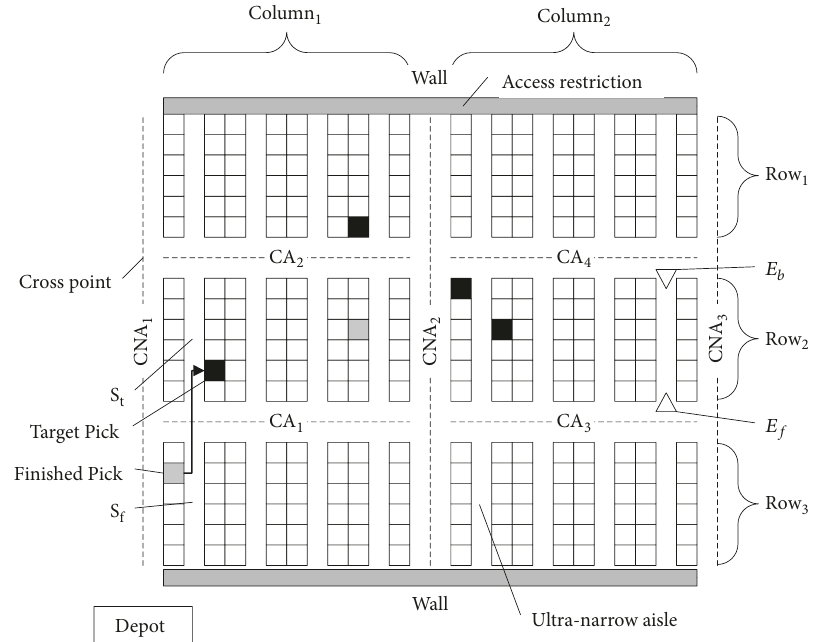
Figure 3: Multiple-block warehouse system with ultranarrow aisles and access restriction.